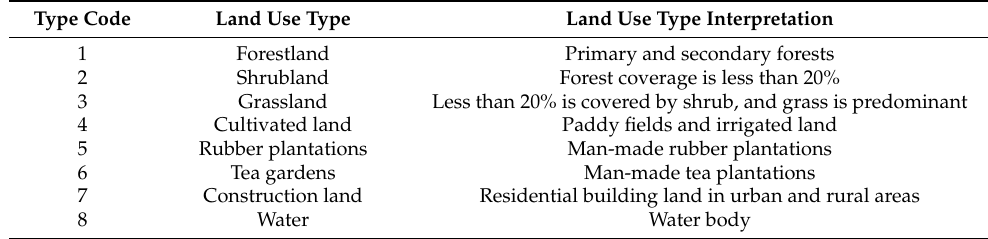
Table 2. Land use classification followed for this